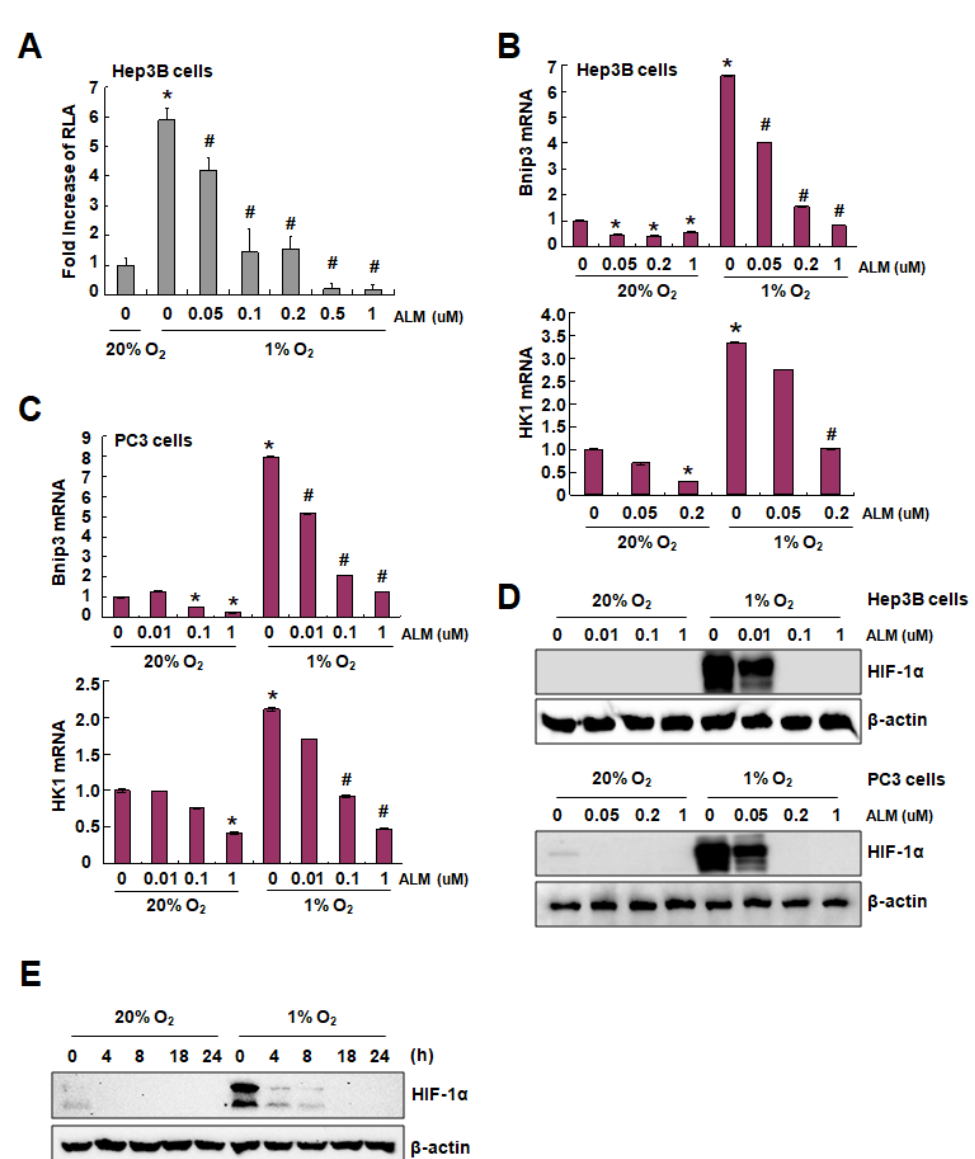
Figure 1. ALM inhibits HIF-1 α transactivity and protein expression. ( A ) Hep3B cells stably expressing P2.1 and pSV-Renilla were exposed to normoxic or hypoxic culture conditions and the effect of ALM on the ratio of firefly/Renilla luciferase activity in hypoxic cells was determined; mean ± SD ( n = 3) are shown. ( B ) Hep3B cells were exposed to vehicle (DMSO) or the indicated concentration of ALM for 24 h under normoxic or hypoxic conditions and total RNA was subjected to RT-PCR assays for HIF-1 target genes Bnip3 and HK1. For each mRNA in each experiment, expression was normalized to the levels in vehicle-treated cells at 20% O 2 . The bars show mean ± SD ( n = 3 each). ( C ) PC3 cells were exposed to vehicle or the indicated concentration of ALM for 24 h under normoxic or hypoxic conditions and total RNA was subjected to RT-PCR assays for HIF-1 target genes Bnip3 and HK1. For each mRNA in each experiment, expression was normalized to the levels in vehicle-treated cells at 20% O 2 . The bars show mean ± SD ( n = 3 each). ( D ) Hep3B and PC3 cells were exposed to vehicle or the indicated concentration of ALM for 24 h under normoxic (20% O 2 ) or hypoxic (1% O 2 ) conditions and cell lysates were subjected to Western blot for HIF-1 α and β -actin. ( E ) PC3 cells were exposed to 100 nM of ALM for the indicated time under normoxic or hypoxic conditions and Western blot was performed, * P < 0.05 as compared with 20% O 2 , 0 µ m ALM group; # P < 0.05 as compared with 1% O 2 , 0 µ m ALM group.